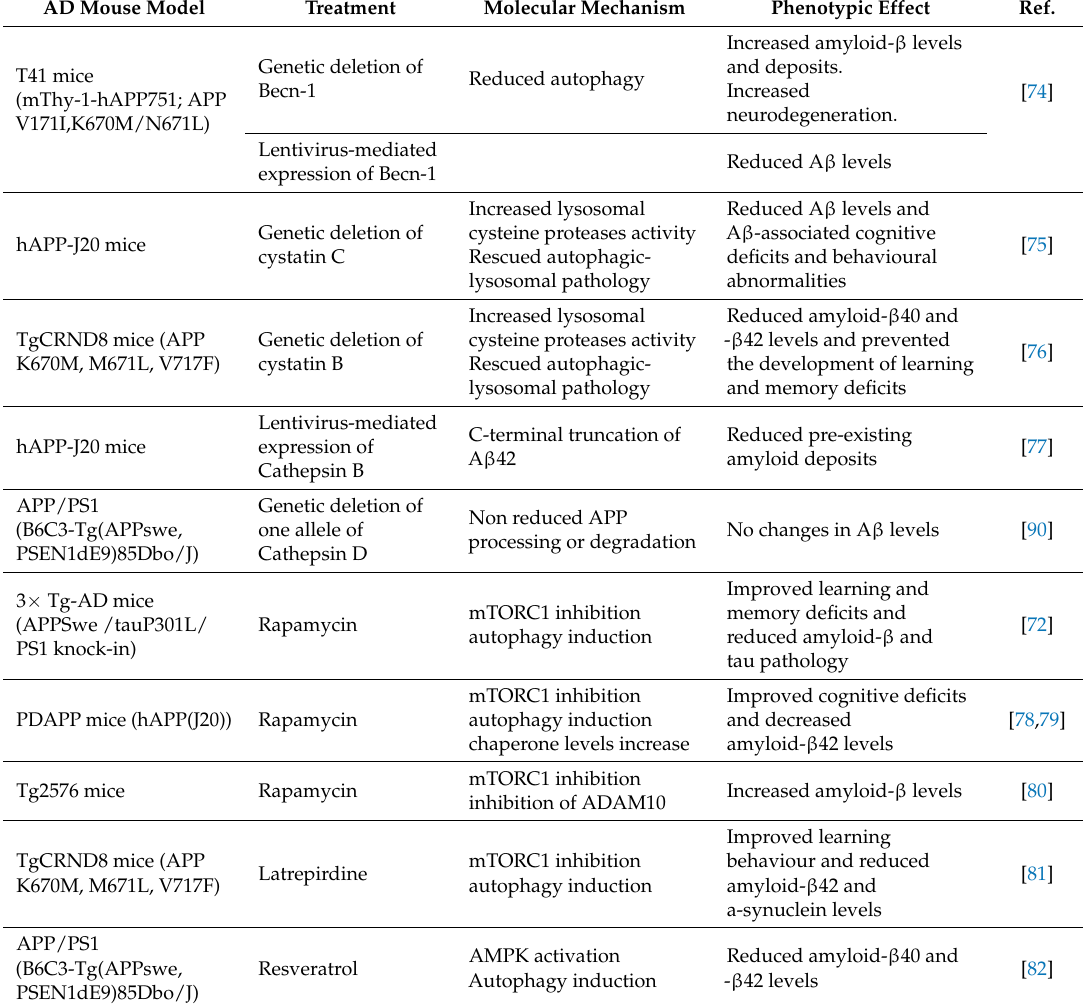
Table 1. Summary of data using different compounds in AD models. The putative mechanism, connecting or not autophagy, and the therapeutic effects were